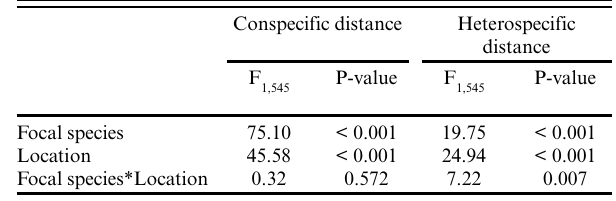
interaction between location and focal species were not significant (Table 3). Heterospecific distance did not significantly covary with clutch size and was only significantly affected by focal species (Table 3). For the proportion of chicks fledged conspecific distance only approached significance although focal species was significant (Table 3). Heterospecific distance was not a significant covariate for proportion fledged and the only significant effect was location (Table 3). Table 2 . Results of GLMM analysis of variance to test the effects of focal species (Blue Tit, Cyanistes caeruleus , or Great Tit, Parus major ), location (Riseholme Park or Treswell Wood), and the interaction on the distances between nest boxes occupied by conspecifics or heterospecifics. Distance values were Log transformed prior to analysis.